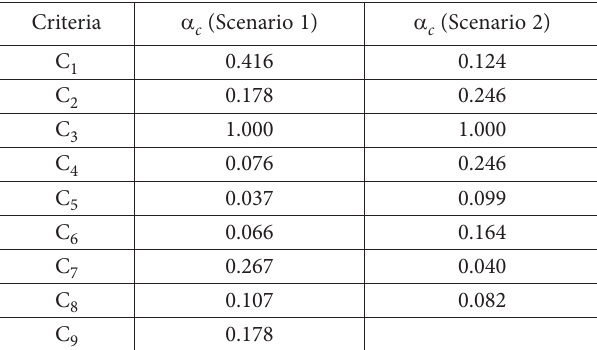
Table 14. The weight coefficients of elasticity for changing weights for both scenarios